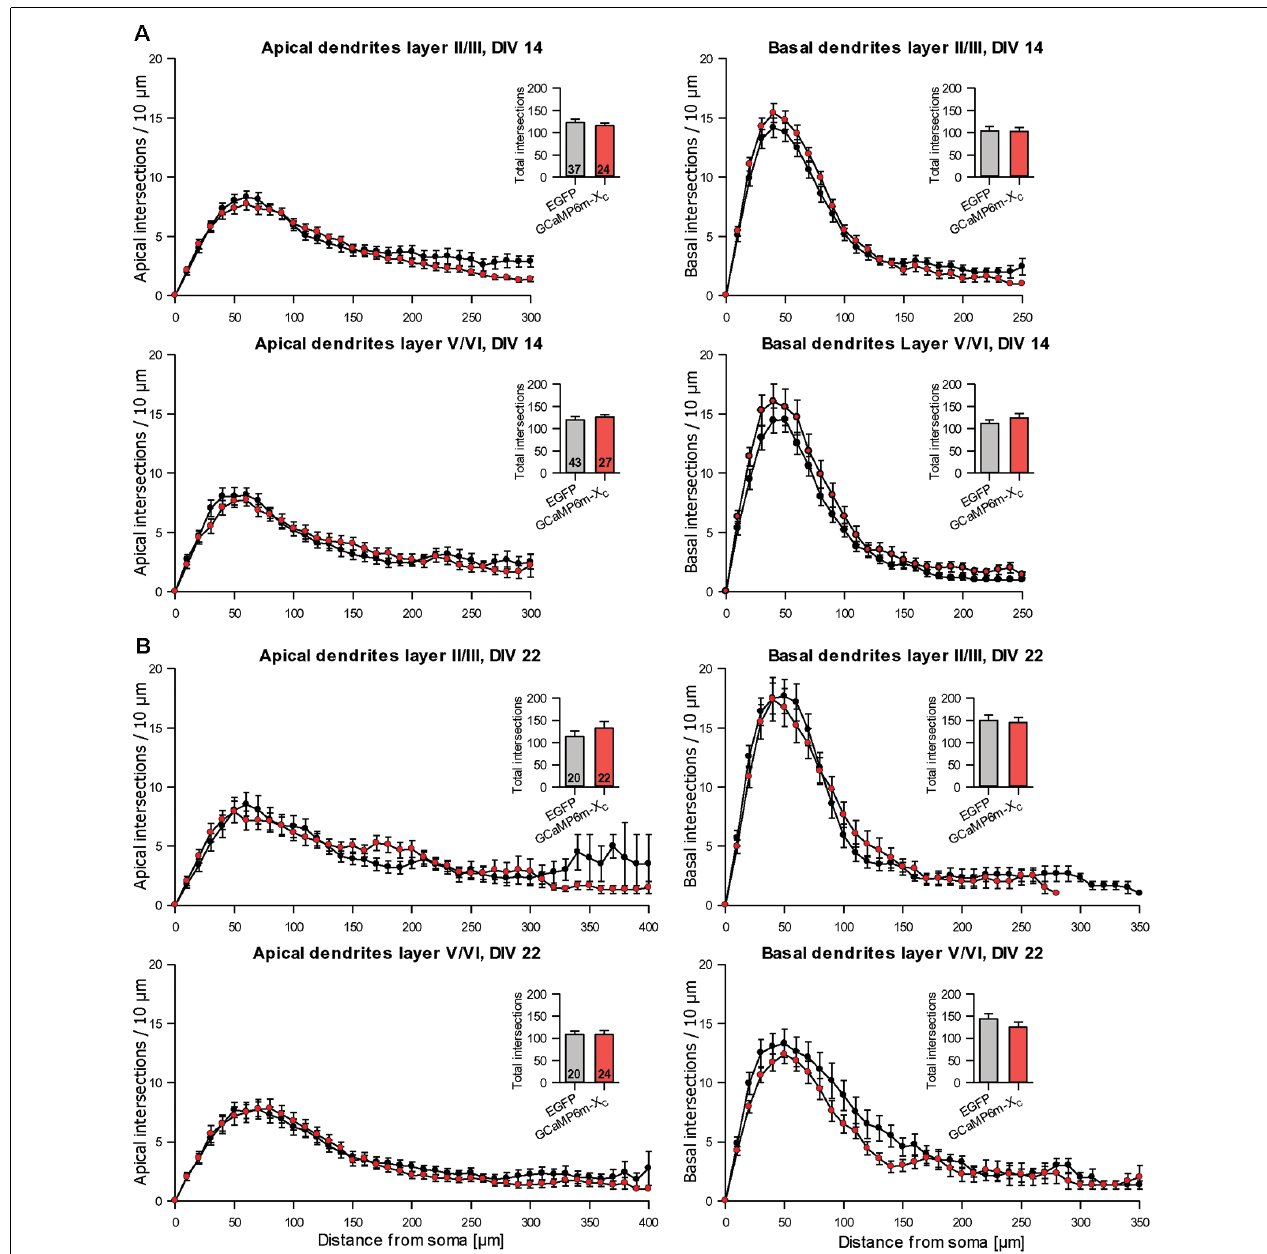
FIGURE 7 | Sholl analyses of apical and basal dendrites of pyramidal neurons of layers II/III and V/VI expressing GCaMP6m-X C vs. batch-internal EGFP expressing neurons. (A) DIV 14. (B) DIV 22. Insets report total